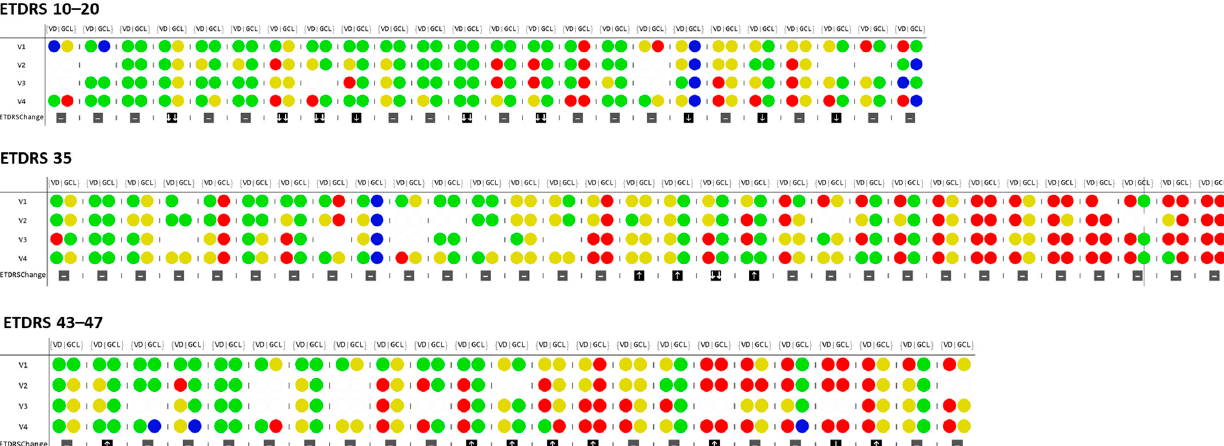
Figure 1. Schematic representation of individual vessel density values in the SCP inner ring and thinning of GCL + IPL and its progression over the four visits, presented according to differences and variation in VD across ETDRS groups. The values are given in relation to the control group: Values within a normal range are depicted in green; 2 SD decrease is depicted in red; 1 SD decrease is depicted in yellow; and 2 SD increase are shown in blue. Circles without color indicate that reliable measurements could not be obtained in that specific visit due to insufficient image quality. Arrows indicate ETDRS step progression: one or two increase ( ↑ ), maintenance (-) or decrease ( ↓ ). VD: Vessel density; GCL: Ganglion cell layer and Inner plexiform layers. V1: Baseline visit; V2: 1 year visit; V3: 2-year visit; V4: Last visit (3